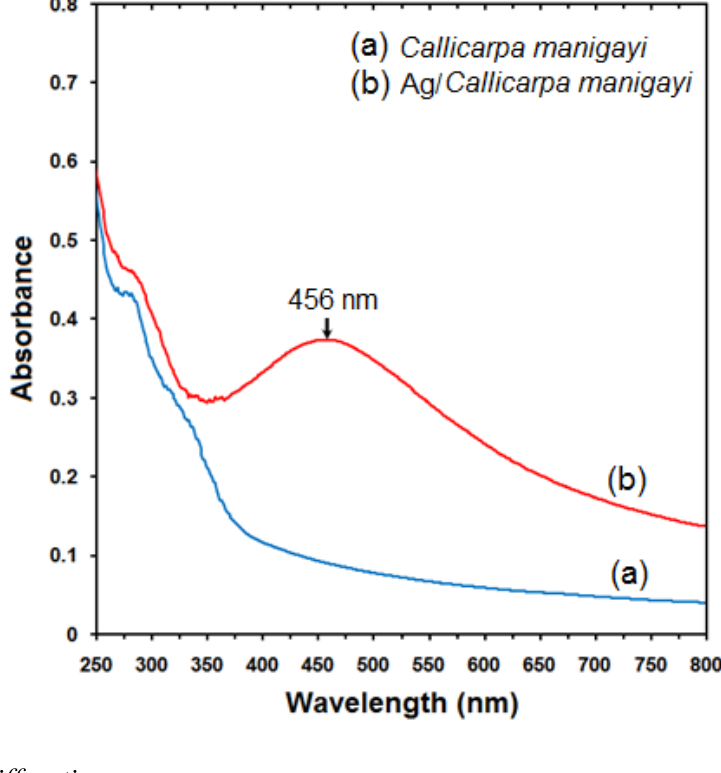
Figure 2. UV-Vis absorption spectra of ( a ) Callicarpa maingayi and ( b ) Ag/ Callicarpa maingayi emulsion after 48